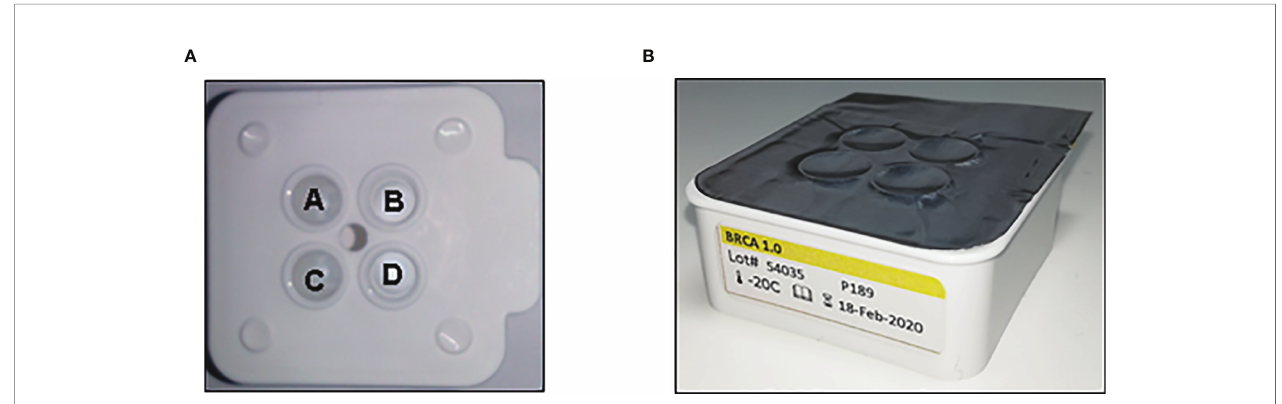
FIGURE 1 | The ParaDNA reaction plate with positions of wells A – D as indicated (A) . The probe mixes for BRCA1 c.1374delC (rs397508862) and BRCA2 c.7934delG (rs80359688) are multiplexed in well A, with mixes for BRCA1 c.2641G>T (rs39750888) and BRCA2 c.5771_5774del (rs80359535) in well B, BRCA1 c.5266dupC (rs80357906) and c.68_69delAG (rs80357914) in well C and BRCA2 c.6447_6448dupTA (rs397507858) and c.5946delT (rs80359550) loaded in well D. (B) The ParaDNA reaction plates are provided foil sealed, ready for